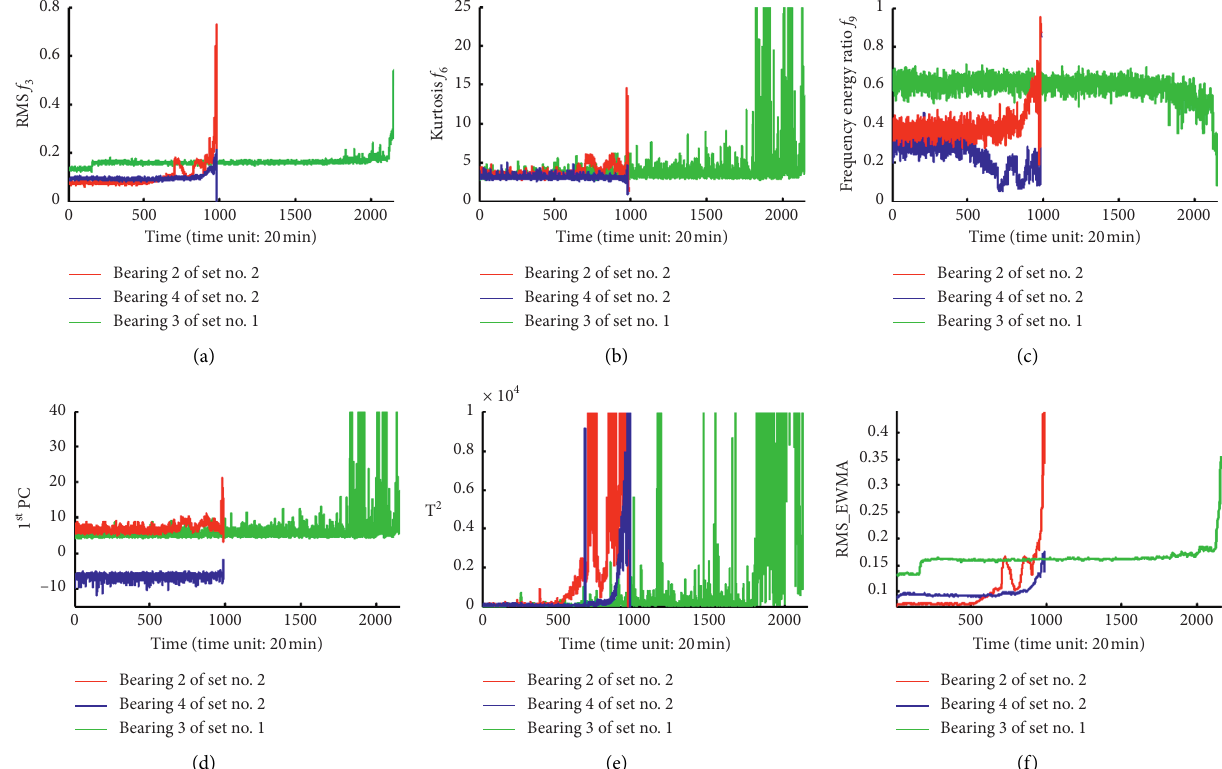
Figure 6: The PDA results for the full cycle life of the tested bearings: (a) the feature RMS ( f frequency energy ratio ( f 9 ), (d) the 1 st PC feature, (e) the T 2 chart, and (f) the indicator RMS_EWMA